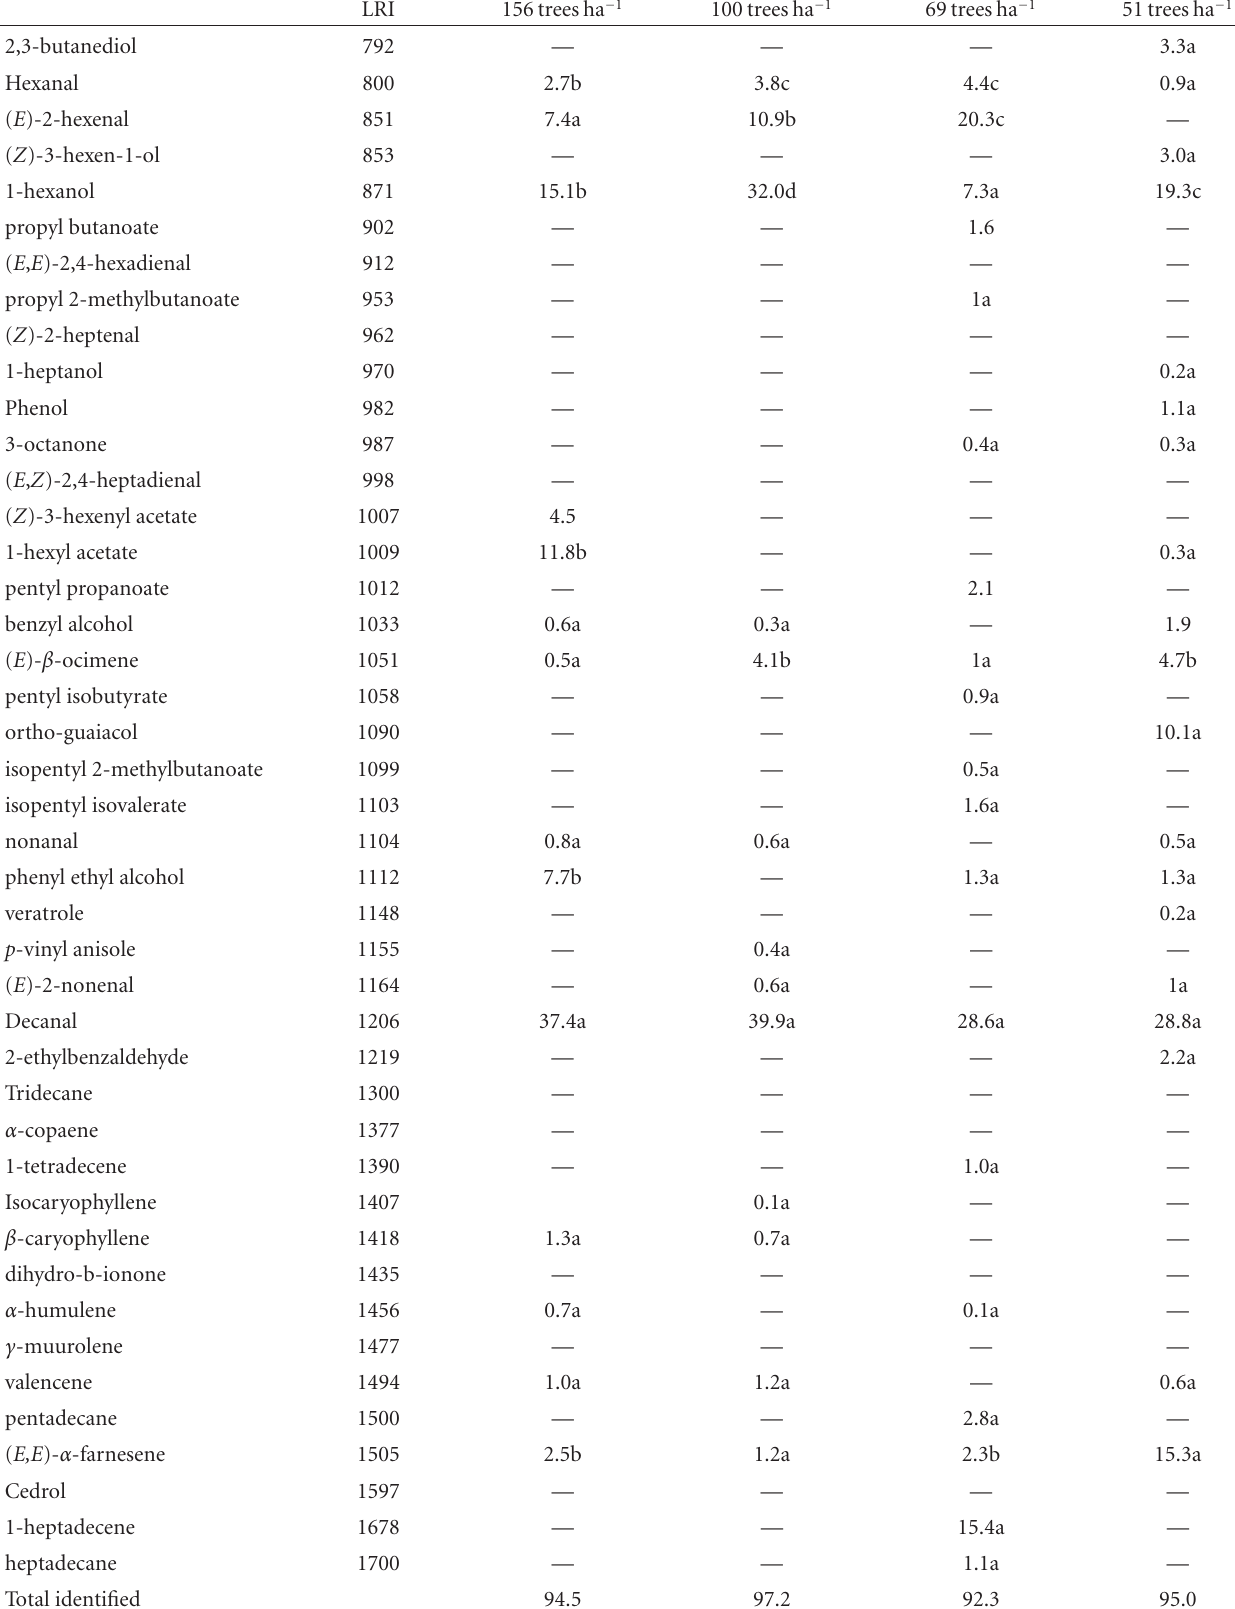
Table 3: Composition of the volatile fraction obtained from Chemlali virgin olive oils extracted by